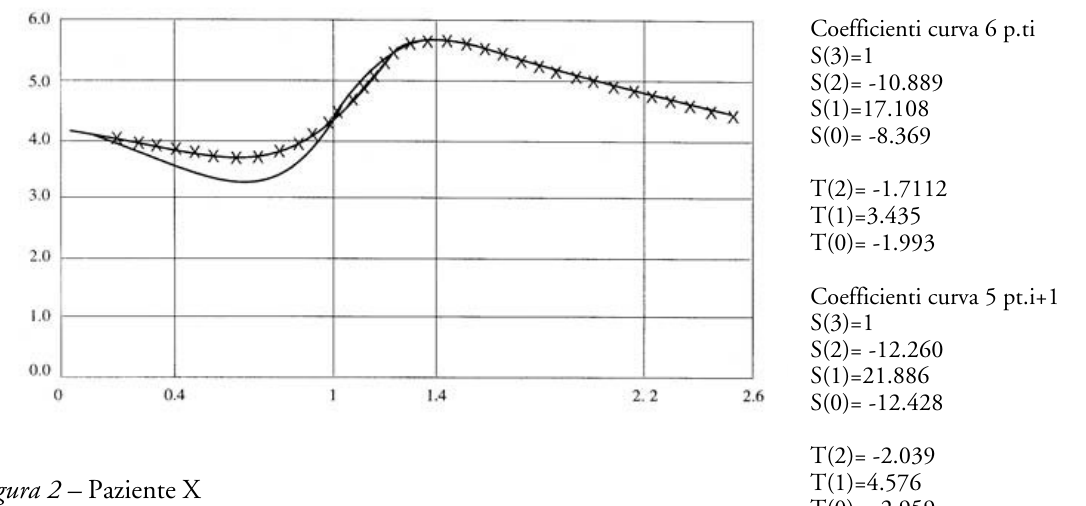
Figura 2 – Paziente X